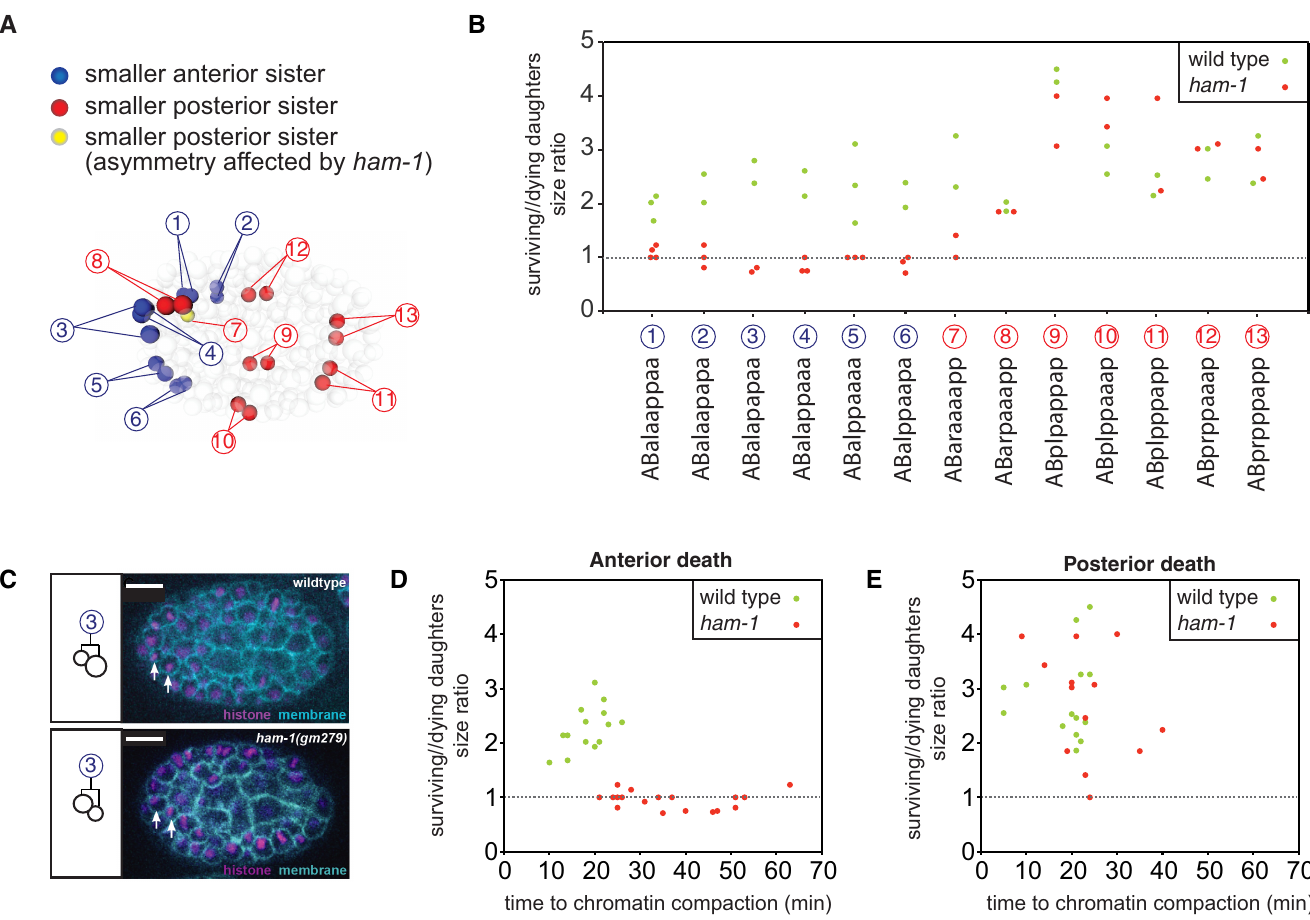
Fig 1. Automated lineaging of 13 neuroblast divisions that produce an apoptotic daughter cell. (A) Schematic representation of an embryo at 265 mins of development showing the positions of the 13 cells (or their daughters) whose divisions were analyzed. Cells are color-coded to describe which ones divide to produce an anterior daughter (blue) or posterior daughter (red) that dies. ABaraaaap (#7), which produces a posterior daughter that dies and whose division asymmetry is affected by ham-1 loss, is labelled in yellow. (B) Asymmetry ratios of all analyzed daughter cells in wild-type (green circles) and ham-1(gm279) (red circles) embryos. The name of the apoptotic cell (e.g., ABalaappaa) is represented along the X-axis with the corresponding number of daughter cells doublet used in (A). (C) A representative division of the ABalapapa cell (#3) yielding an anterior apoptotic daughter in wild-type (upper panel) and ham-1(gm279) (lower panel) embryos. Arrows indicate the two daughters, with anterior to the left. In the ham-1(gm279) mutant embryos, the asymmetry is reversed and reduced. The plasma membrane is labeled with pie-1 :: PH :: mCherry and the nucleus is visualized with his-72 :: HIS-72 :: GFP (REFs). Scale bars: 10 μ m. (D, E) Comparison of asymmetry ratios for wild-type and ham-1(gm279) embryo to the time of chromatin compaction, a marker for apoptosis.